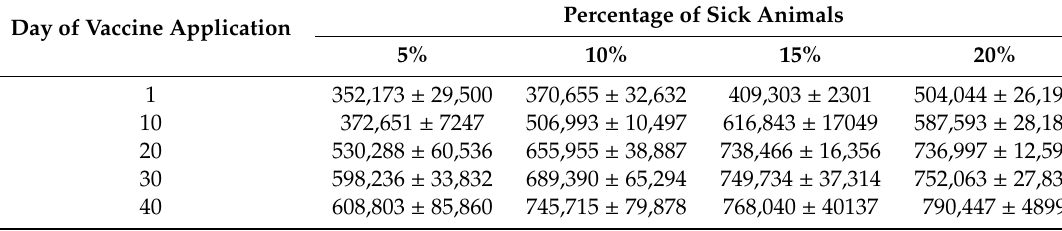
Table 4. Annual direct economic losses (Euros) for a 1000-sow farm (mean ± SD) in relation to the number of days between infection and vaccination and the percentage of sick animals at the beginning of the nursery phase. It is assumed that the disease a ff ects every production